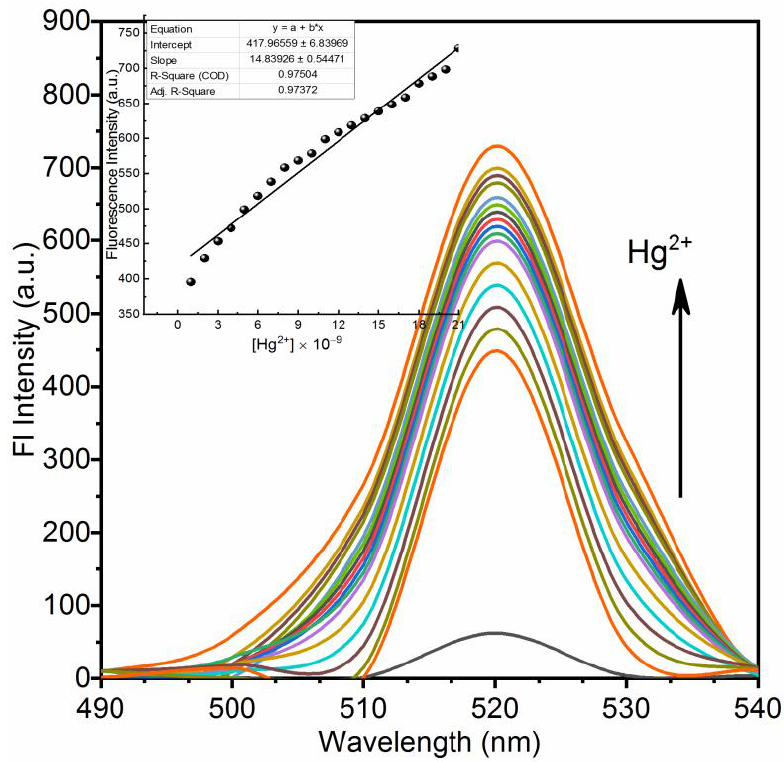
Figure 4. Emission spectra of the sequential addition of Hg 2+ ions (1–20 nM) in 10 ppm of nano- composite (12) ; inset linear fitting plot to calculate LOD and LOQ @520 nm.